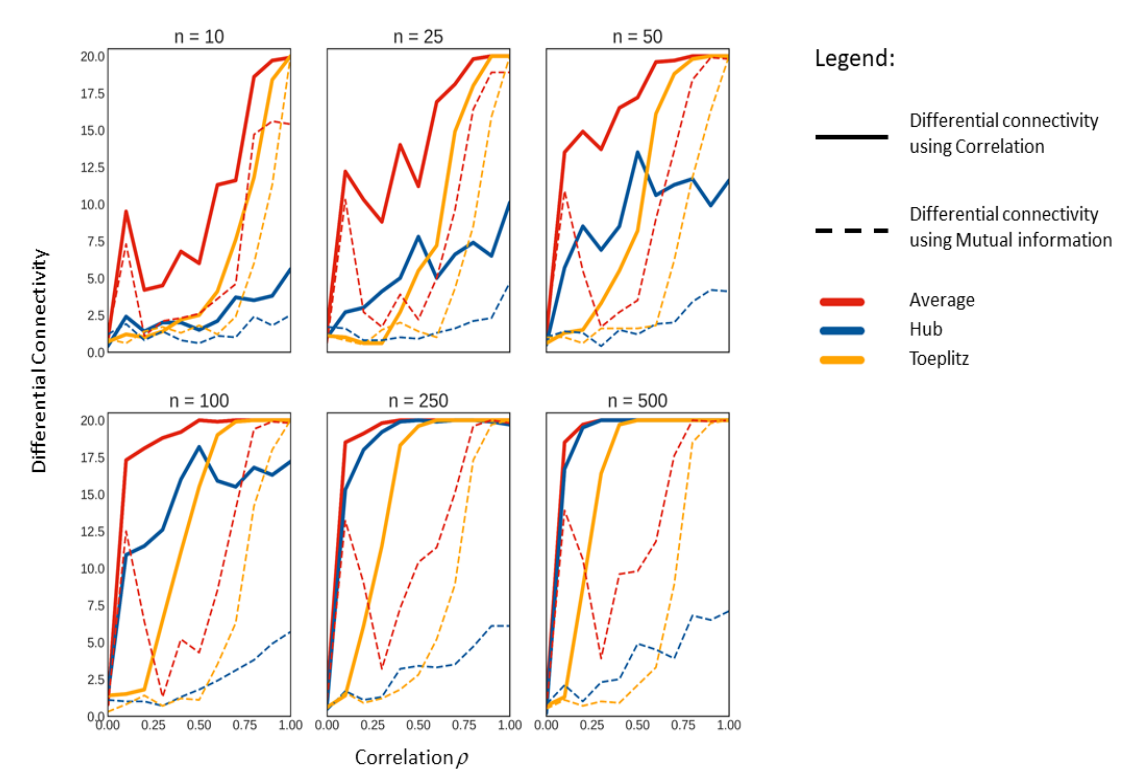
Figure 5. Median of the significant differentially connected variables on all simulated data sets per known correlation ρ per sample size n